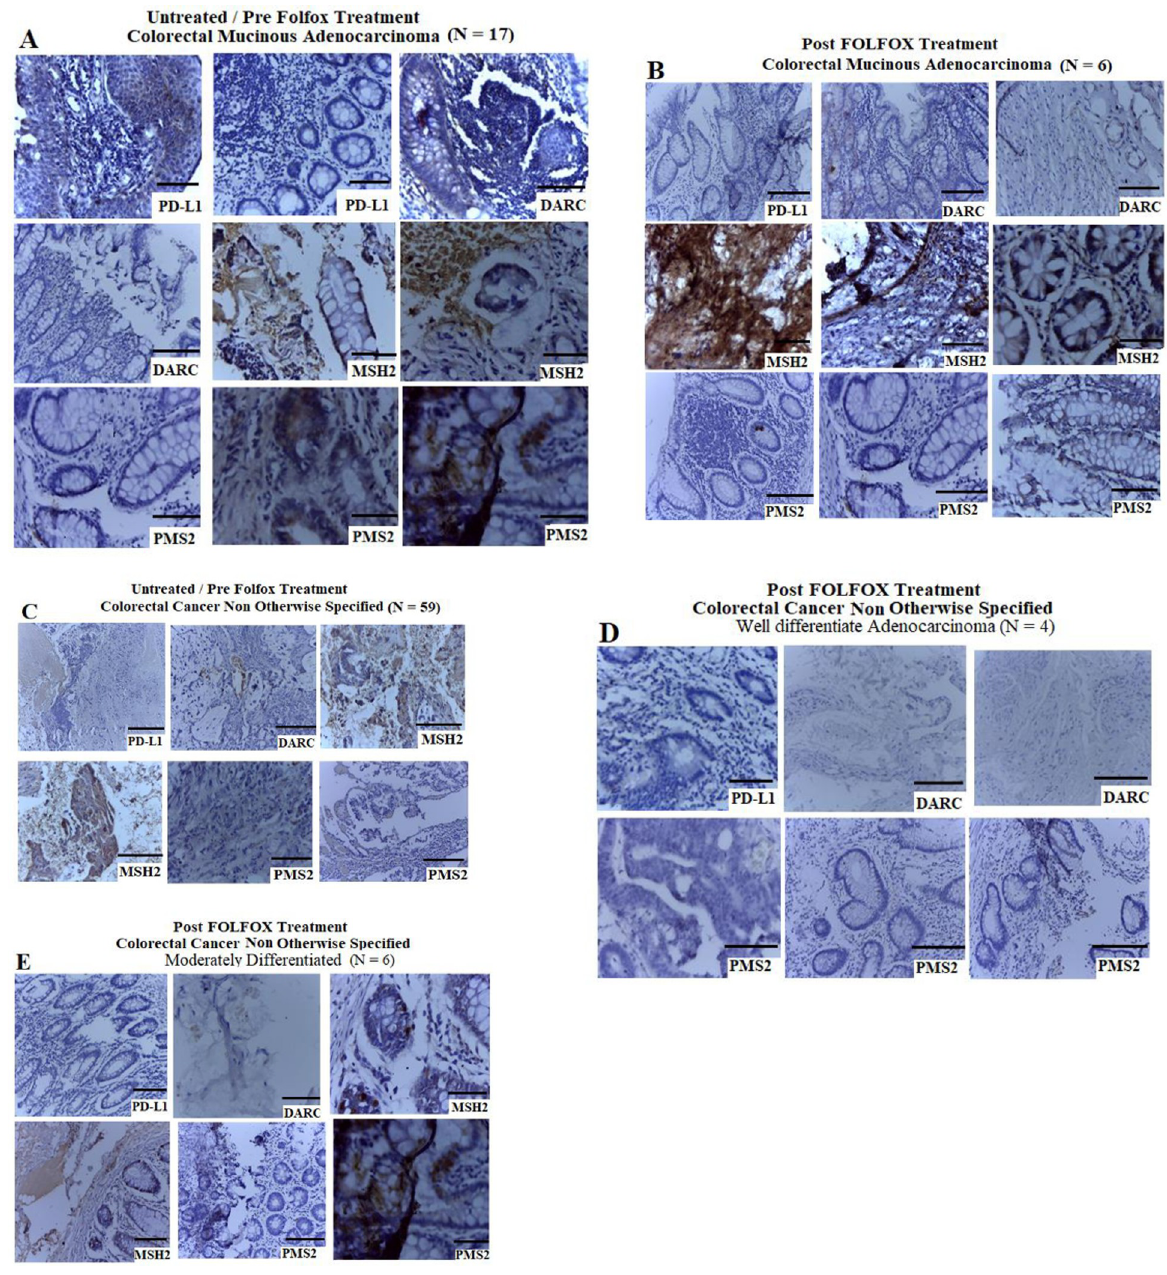
Fig 8. Prognostic significance of PD-L1, DARC and DNA mismatch repair proteins MSH2 and PMS2 in human CRC treated with and without neoadjuvant FOLOFOX (scale bar = 50 μ m for H&E and scale bar = 100 μ m for IHC). Colorectal adenocarcinoma sections showing negative expression of the PD-L1, DARC and PMS2 and positive expression of MSH2 in mucinous CRC pre and post-FOLFOX treatment (A and B) , and pre and post-FOLFOX treated CRC NOS (C—E) . of aspirin plus FOLFOX compared with the normal sections ( p 0.0013) and also a concurrent dose of aspirin plus FOLFOX compared with the normal section (Fig 9H, p = 0.0043). The quantitative analyses demonstrated a significant increase in PMS2 protein expression from the untreated CRC sections compared with sections treated with 25 mg/kg aspirin ( p = 0.0023)